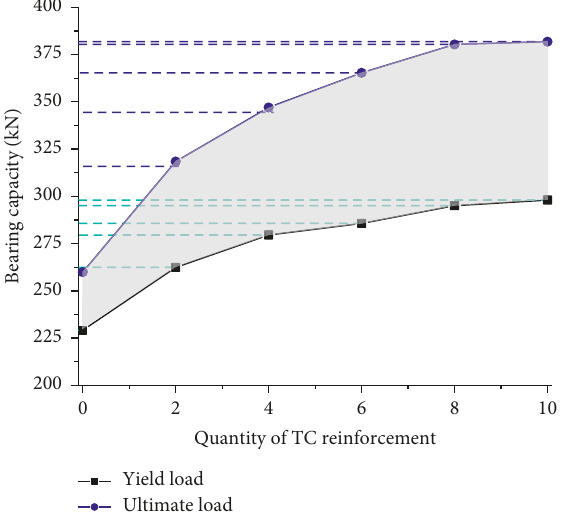
Figure 16: Effect of flange width reduction ratio.